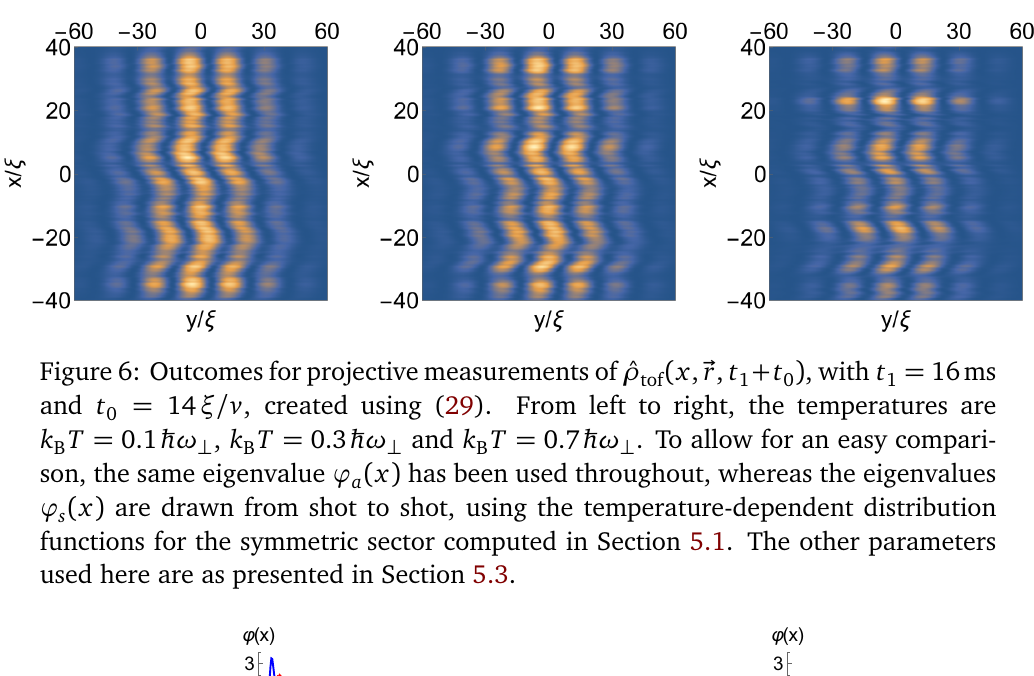
Figure 7: (a) Individual realization of the eigenvalue ϕ ( x ) ( red ) at time of flight t extracted phase ˜ ϕ a objects, convolved with a Gaussian kernel of width ξ = ħ h π/ mv . The parameters